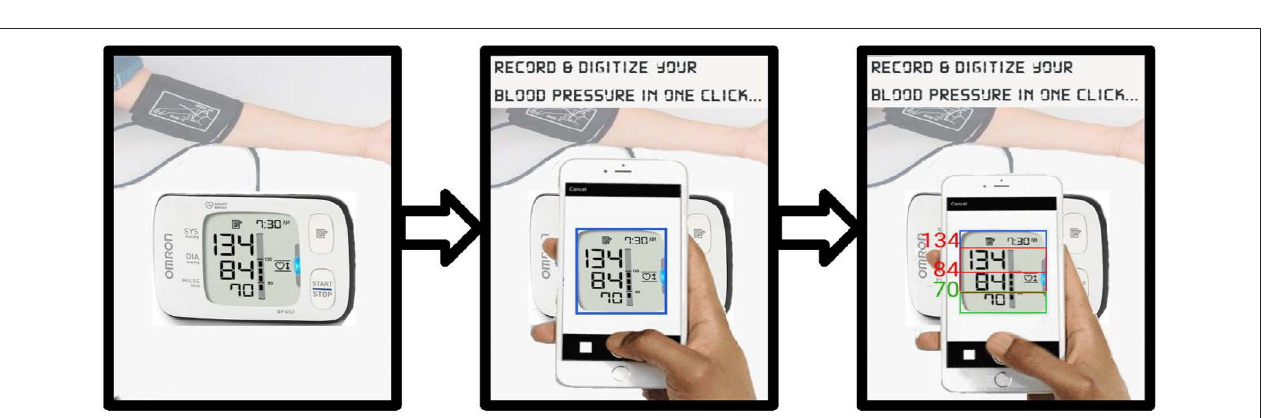
FIGURE 1 | An Android-based app to capture blood pressure readings used in this study: (A) The app being used by traditional birth attendants in Highland Guatemala is shown ( NBC Universal News Group, 2017). (B) The app interface as seen by the user is shown, with a “mask” to help align the liquid crystal display (LCD) and improve quality during capture.